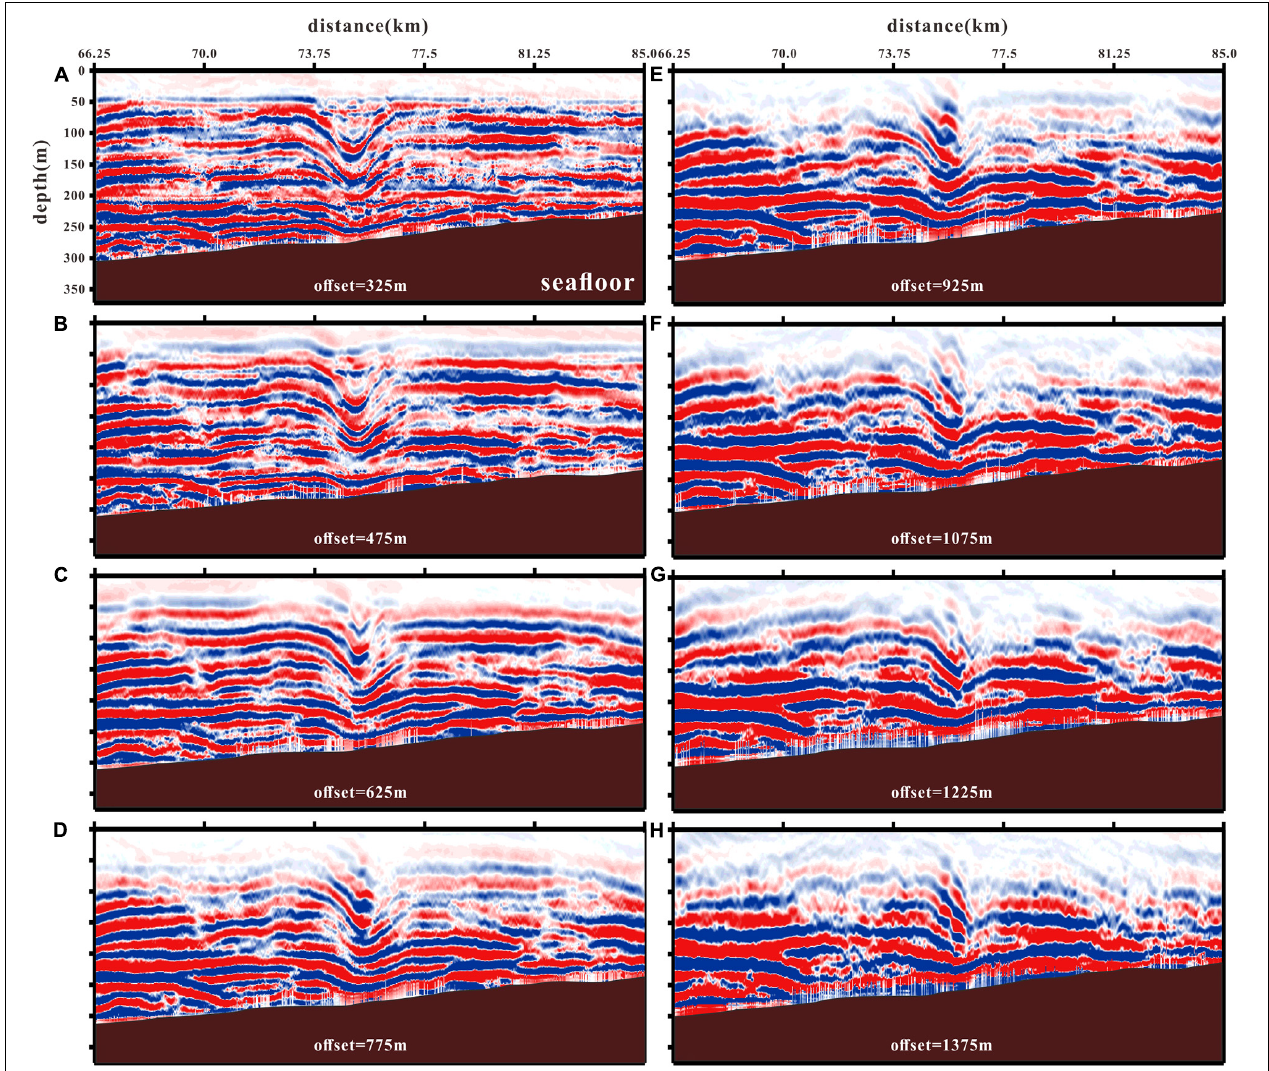
FIGURE 5 | (A–H) Common offset gather (COG) migrated sections with different offsets. For conciseness, only eight sections are shown out of 23 collected. The brown areas represent topography. Seismic section displayed in color and red events are traced to study the internal solitary wave